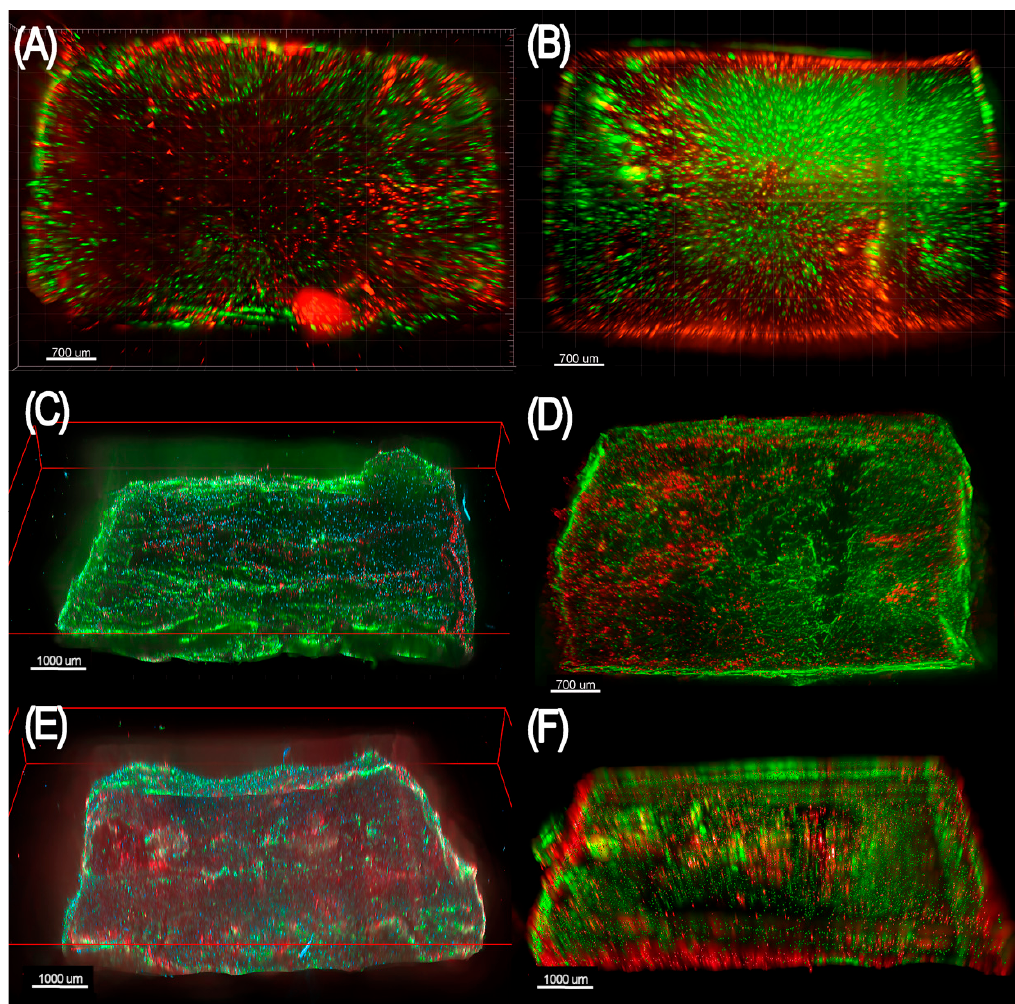
Figure 5. Panel showing epifluorescence microscopy of scaffolds made of poly(ethylene glycol) diglycidyl ether-chitosan ( A , C , E ) and the same material within a poly(L-lactic acid), poly( 𝜀 -caprolactone) blend ( B , D , F ). ( A , B ) The scaffolds were seeded with 1000 cell/mm3 hBM-MSCs and stained with calcein (green, live cells) and propidium iodide (red, dead cells) 4 days ( A ) and 11 days ( B ) after seeding. ( C , D ) The scaffold was seeded with 2000 cell/mm3 hBM-MSCs and stained with Ki-67 (red, actively proliferating cells), 4 ′ ,6-diamidino-2-phenylindole (DAPI) (blue, nuclei), and phalloidin (green, cytoplasm) 11 days after seeding. ( E , F ) The scaffolds were seeded with 2000 cell/mm3 hBM-MSCs, stimulated with osteogenic medium, and stained with anti-osteocalcin antibody (red, osteocalcin-producing cells and extracellular osteocalcin), 4 ′ ,6-diamidino-2-phenylindole (DAPI) (blue, nuclei), and phalloidin (green, cytoplasm) 21 days after seeding.